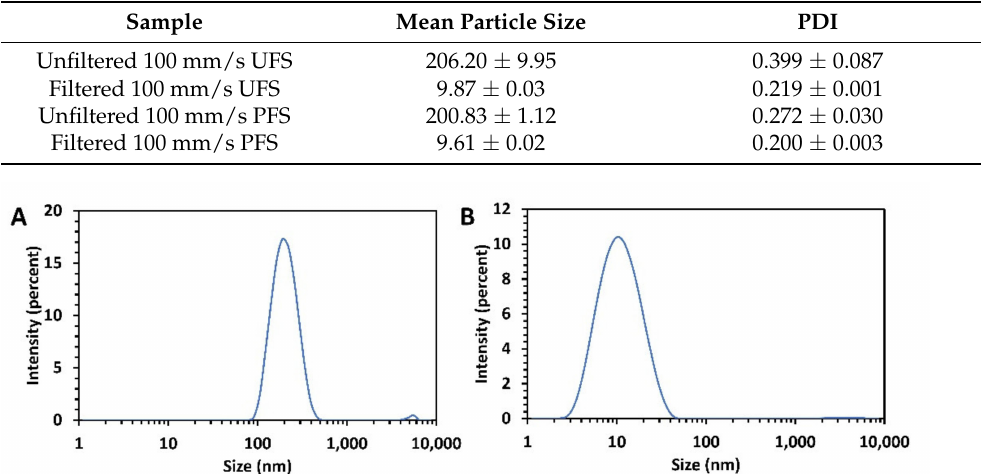
Figure 9. Particle size analysis for the PFS 100 mm/s tablets at pH 2 ( A ) Unfiltered sample ( B ) Filtered sample (0.2 µ m PES